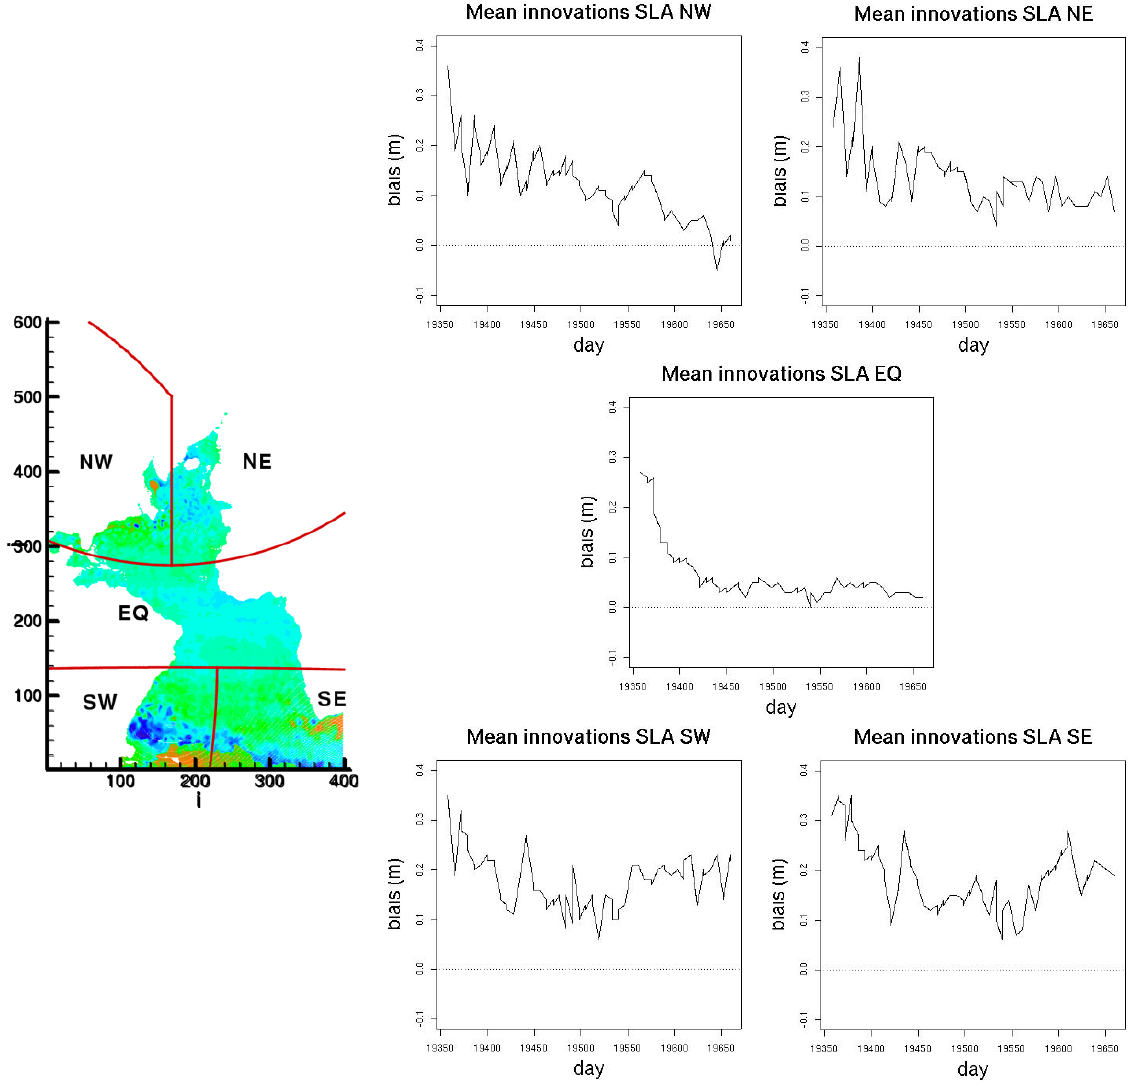
Fig. 8. Decomposition of the TOPAZ model domain with a map of SLA innovations as background (left) and evolution of the mean error in each of the five sub-domain during from January to December 2003